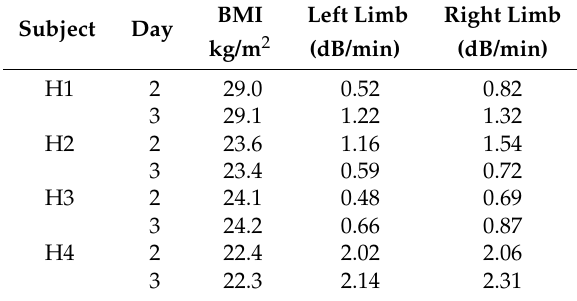
Table 5. Deviation in time of galvanic signal attenuation on healthy participants, Day 2, without fluid restriction, and Day 3, after fluid restriction and ingestion of 350 mL of